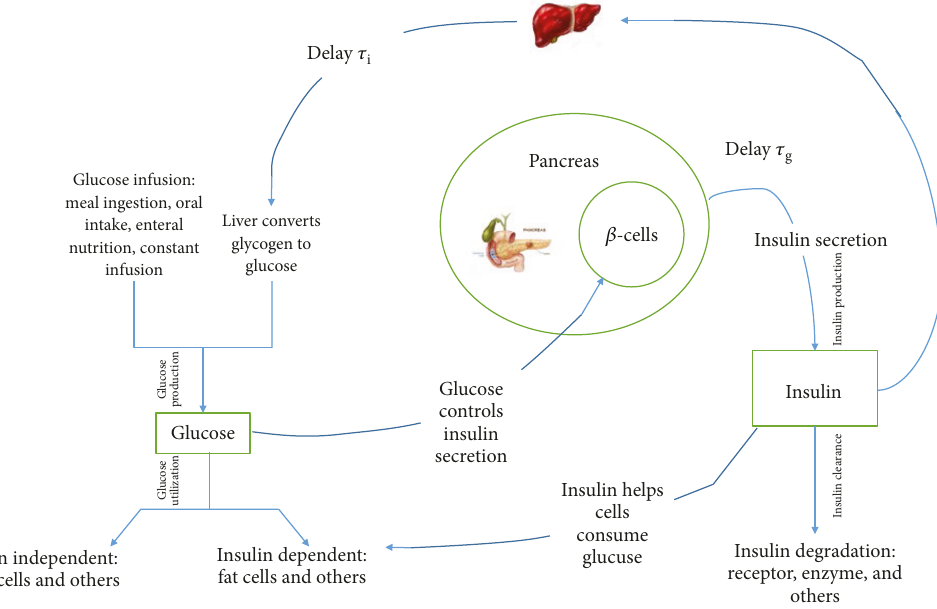
Figure 1: Two time delays in glucose-insulin system